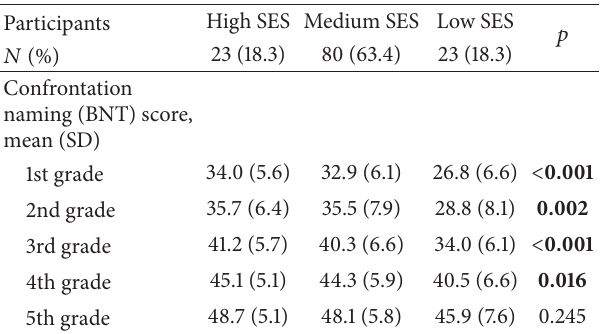
Table 4: Confrontation naming (BNT) scores obtained at the end of each grade by SES group. Comparisons were made by one-way ANOVA test (Bonferroni post hoc